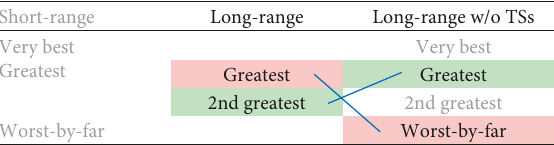
Table 13: Tabular representation of Rule 4.